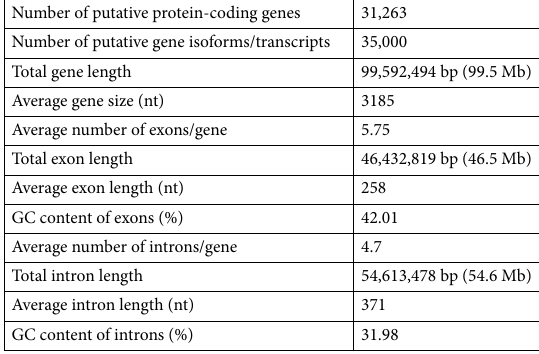
Table 3. Annotation statistics for A. occidentale genome.